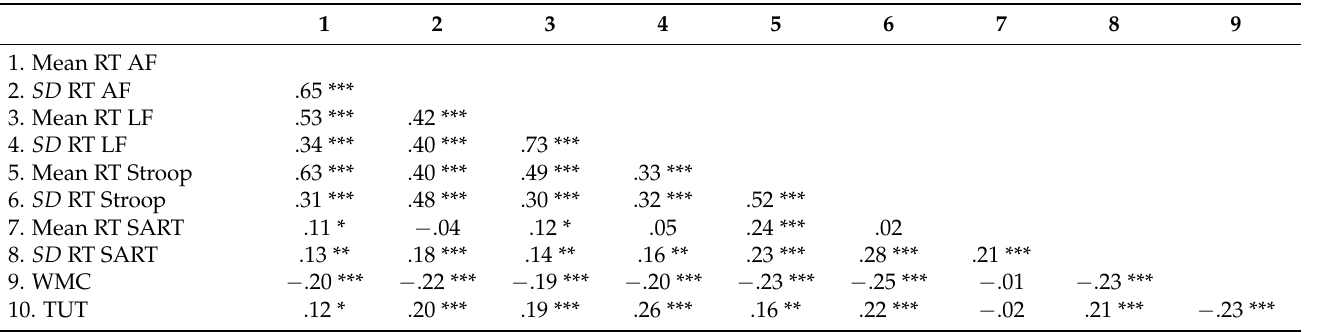
Table 6. Correlations between all